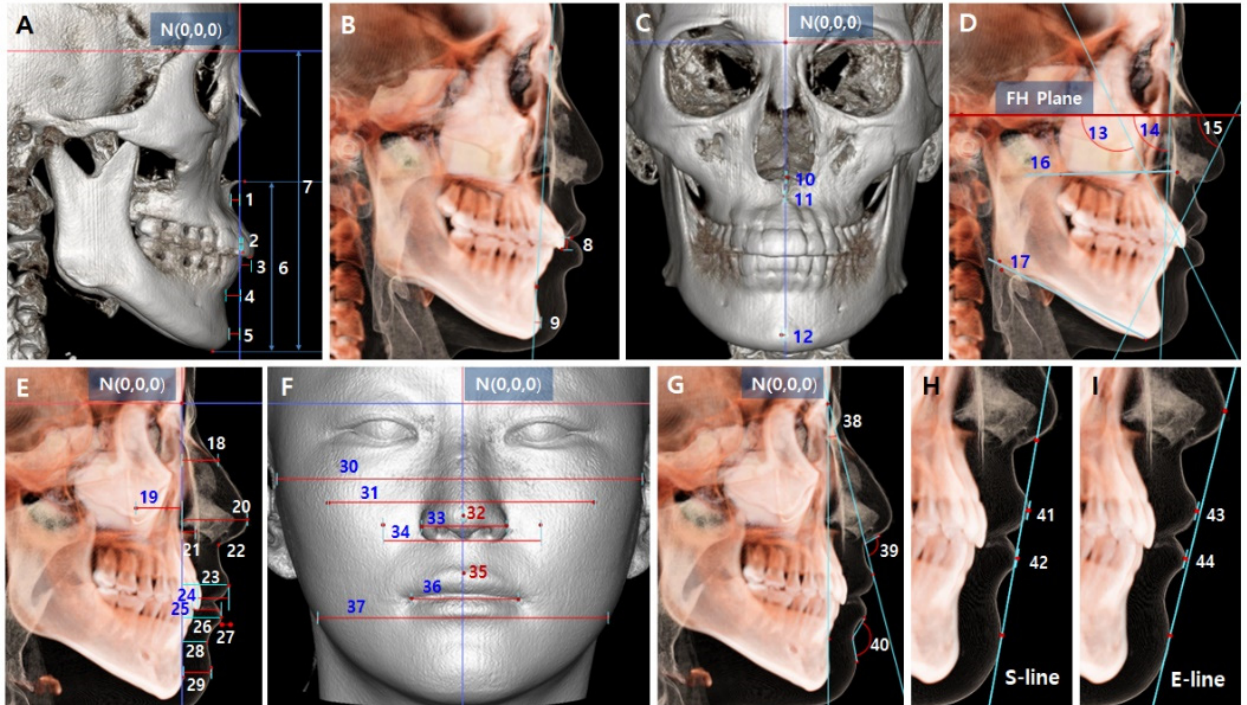
Figure 3. Three-dimensional values. ( A,B) Skeletal and dental linear values in the sagittal view: 1,